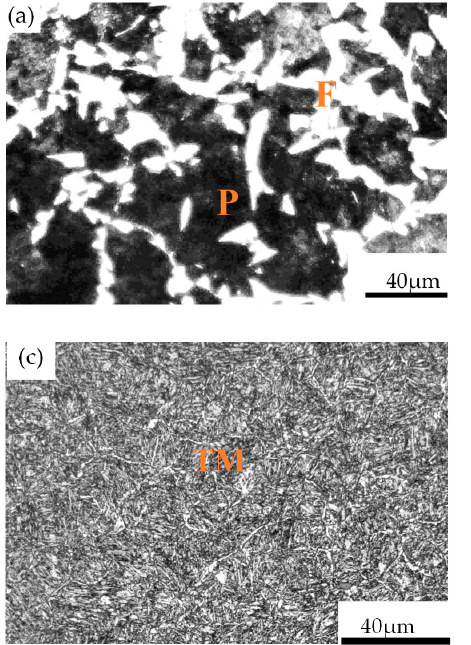
Figure 2. Optical micrographs of casing drilling steels. ( a ) Micrograph of K55 steel; ( b ) micrograph of N80 steel; ( c ) micrograph of P110 steel.